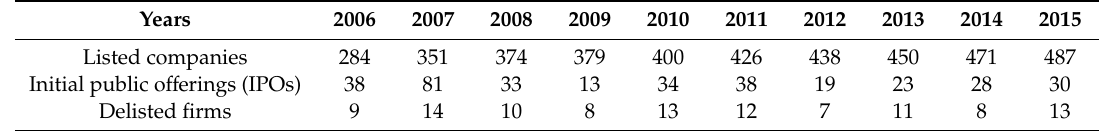
Table 1. Number of companies listed on the Warsaw Stock